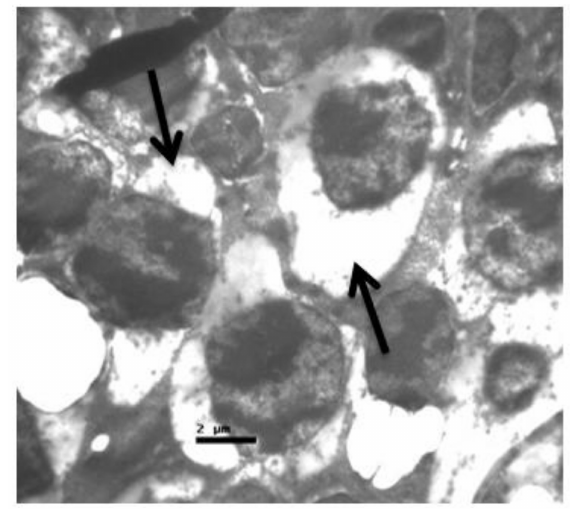
Figure 9. Group V. Rods and cones with sparse cytoplasm around the nucleus in the outer nuclear layer. ( ↑ ).